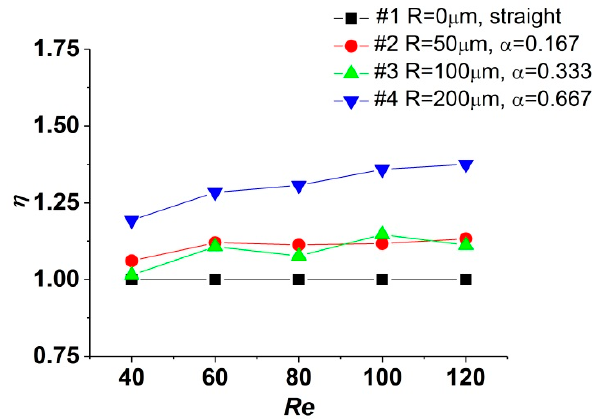
Figure 8. Influence of α on thermal performance factor ( η ) .